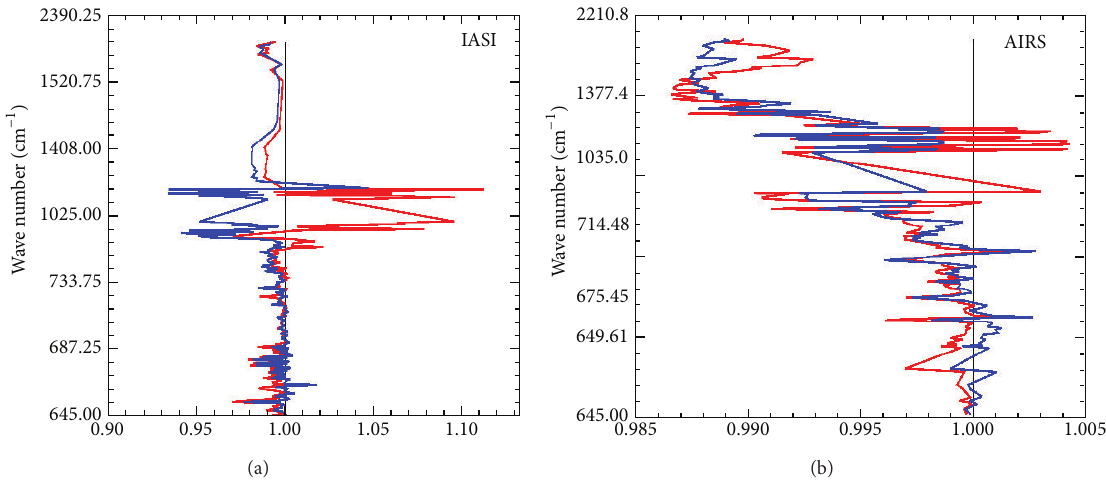
Figure 11: Standard deviation of corrected brightness temperature difference for IASI (a) and AIRS ((b) not a linear scale on the 𝑦 -axis), normalised with respect to the control experiment (black). Red line shows the results for operational thinning; blue line shows the results for reduced thinning (28 June–28 August 2012).